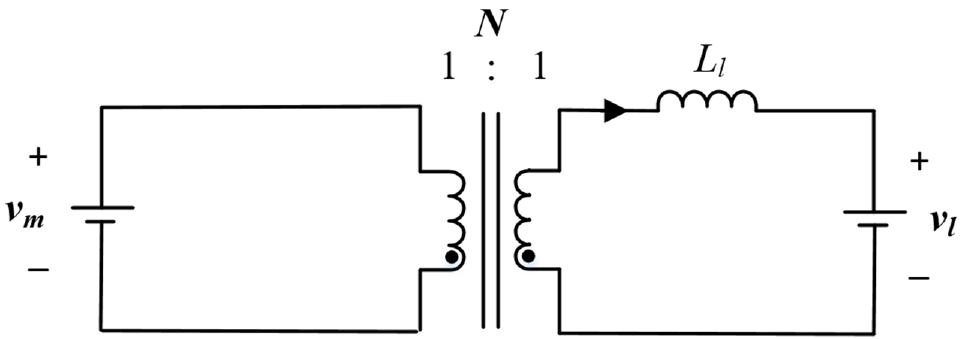
Figure 7. Operation graph of voltage balancing ( a ) before balancing control and ( b ) after balancing control.